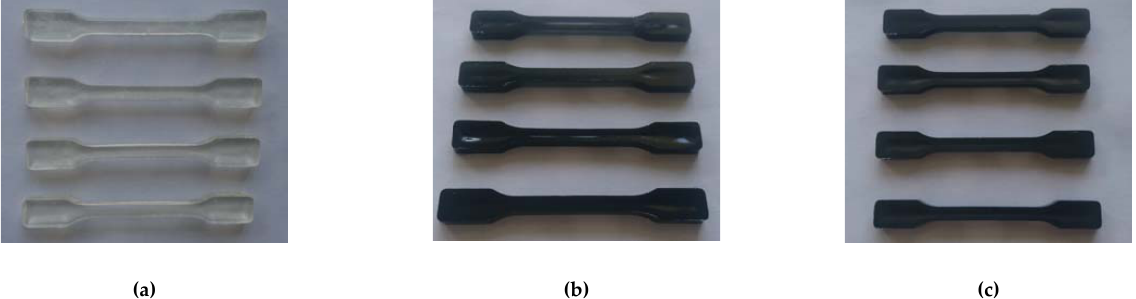
Figure 4. Composite PLA with CNTs in the form of cut pieces ( a ) and composite PLA with GNP in the form of cut pieces ( b ).